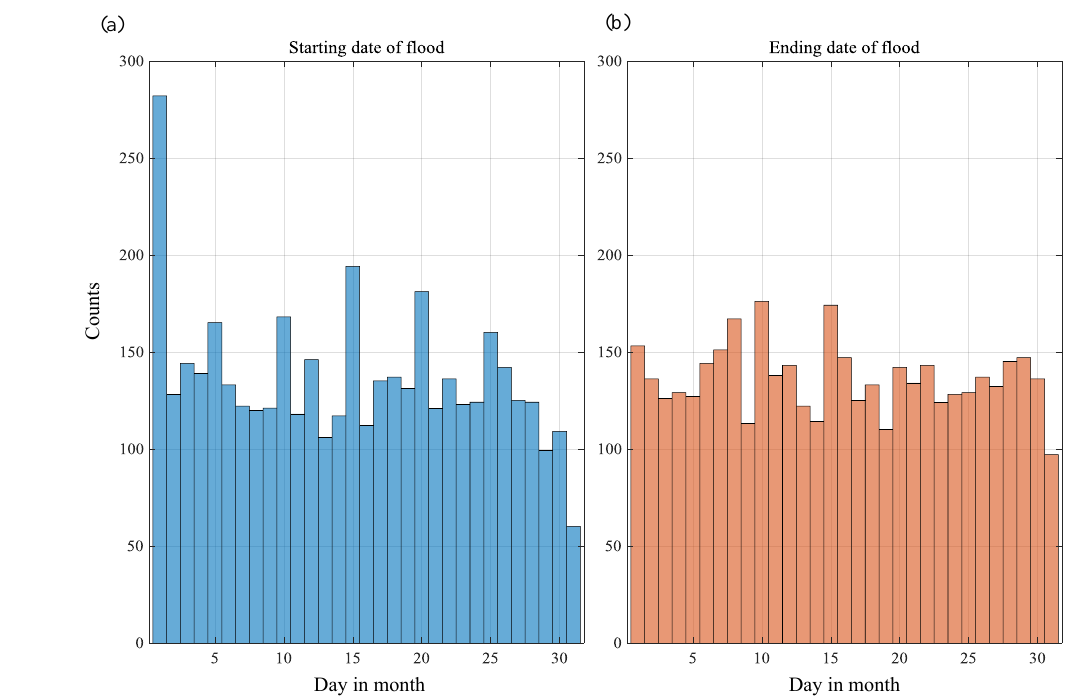
Figure B2. Distribution of the start (a) and end dates (b) of the floods within a month from the DFO database at the global scale (1985–2015).